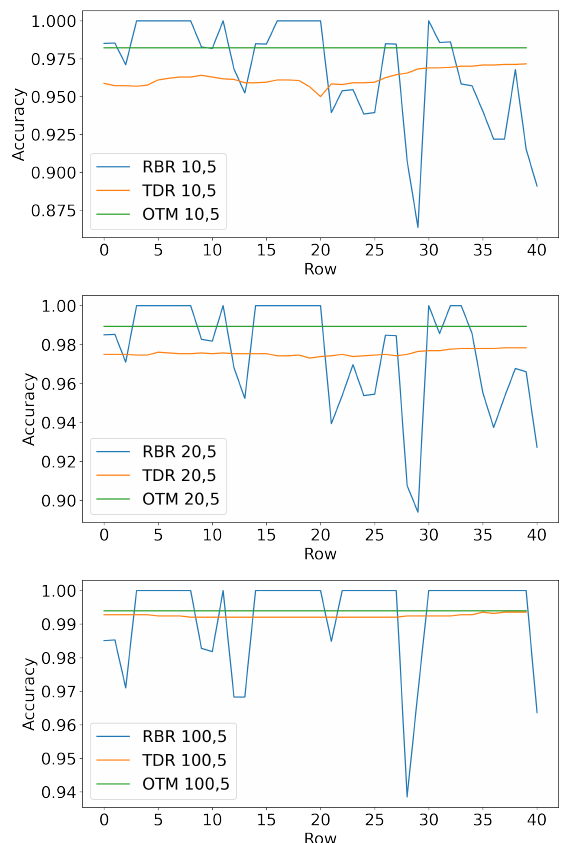
Figure 6: Visualisation of the self-learning MLM accuracy re- sults. RBR: self-learning MLM, one-row accuracy, test data is original image’s next row from the current update row. TDR: self-learning MLM, the accuracy of the whole classified test data, measured after very row-by-row model updates. OTM: once age: classwise R size : 10, number of neighbours: 5, second